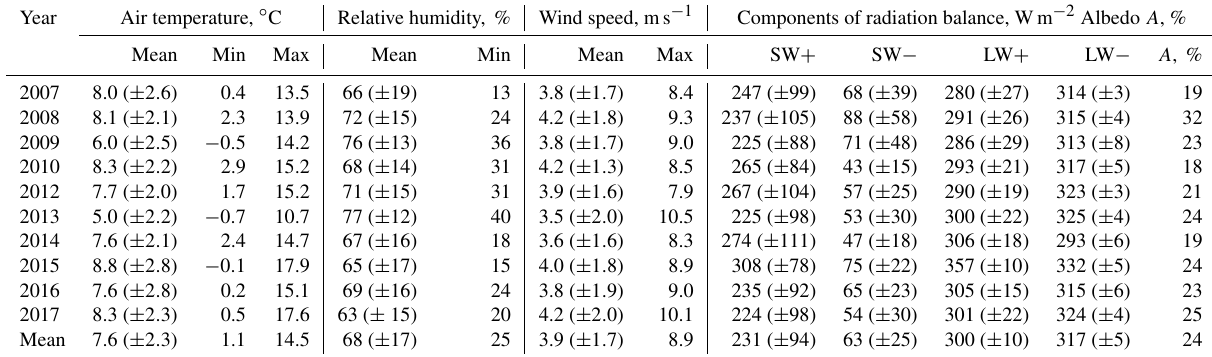
Figure 10. An example of temporal variability of average daily values on the Djankuat glacier (measured at Djankuat glacier AWS 1 location) in 2007: RB – radiation balance, KJm − 2 ; RH – relative humidity; % T2m – air temperature, ◦ C; W – wind speed, ms − 1 . Table 4. July daily averaged meteorological variables on Djankuat glacier from 2007 to 2017 (with rms in brackets). Year Air temperature, ◦ C Relative humidity, % Wind speed, ms − 1 Components of radiation balance, Wm − 2 Albedo A ,